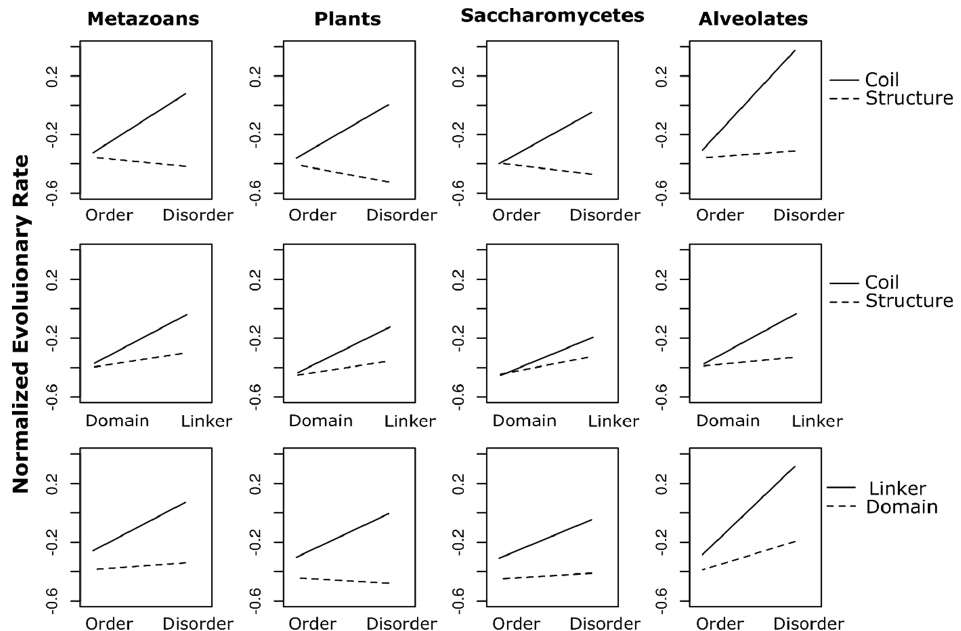
Figure 3. Trace plots illustrating first-order interactions among all site-wise binary factor levels: order (Order) and intrinsic disorder (Disorder), secondary structures (Structure) and random coils (Coil), functional domains (Domain) and interdomain linkers (Linker). Trace factors (solid vs. dashed lines) are indicated to the right of each row of plots. Vertical columns of plots correspond to each of the four datasets (indicated) above. Y-axes represent mean normalized evolutionary rates.